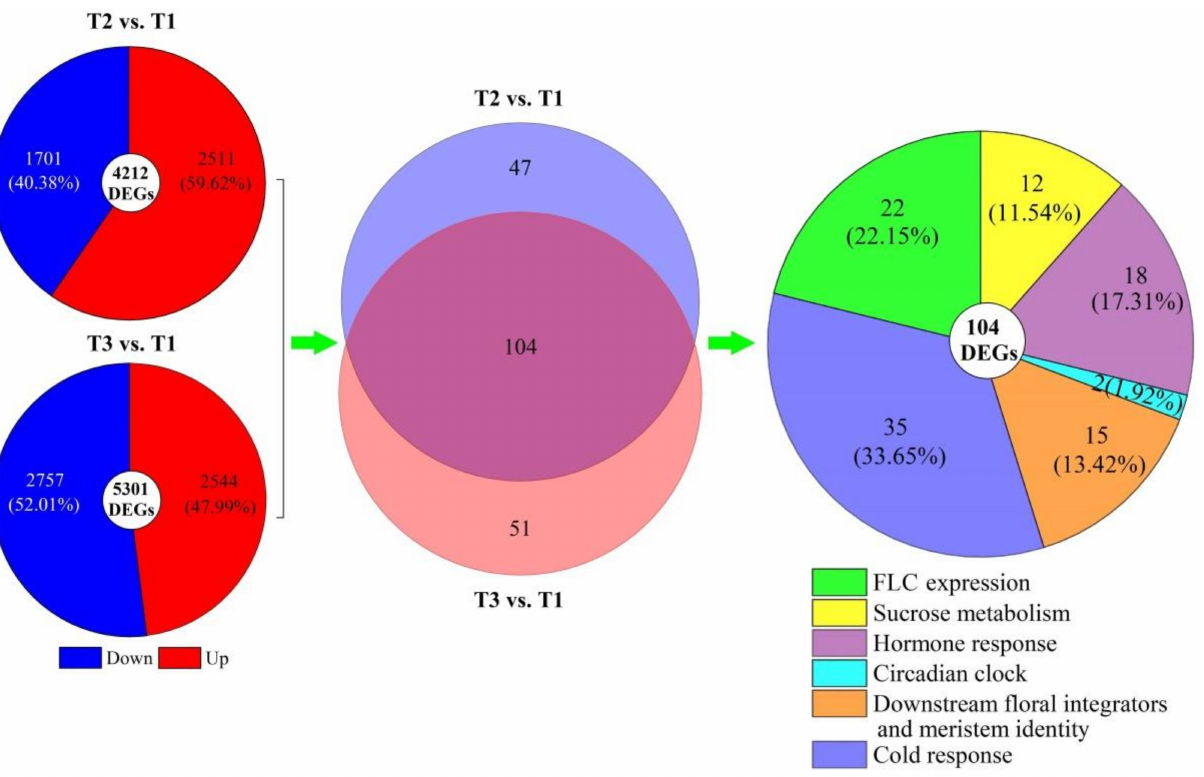
Figure 4. Distribution and classification of DEGs in A. sinensis at T2 vs. T1 and T3 vs.